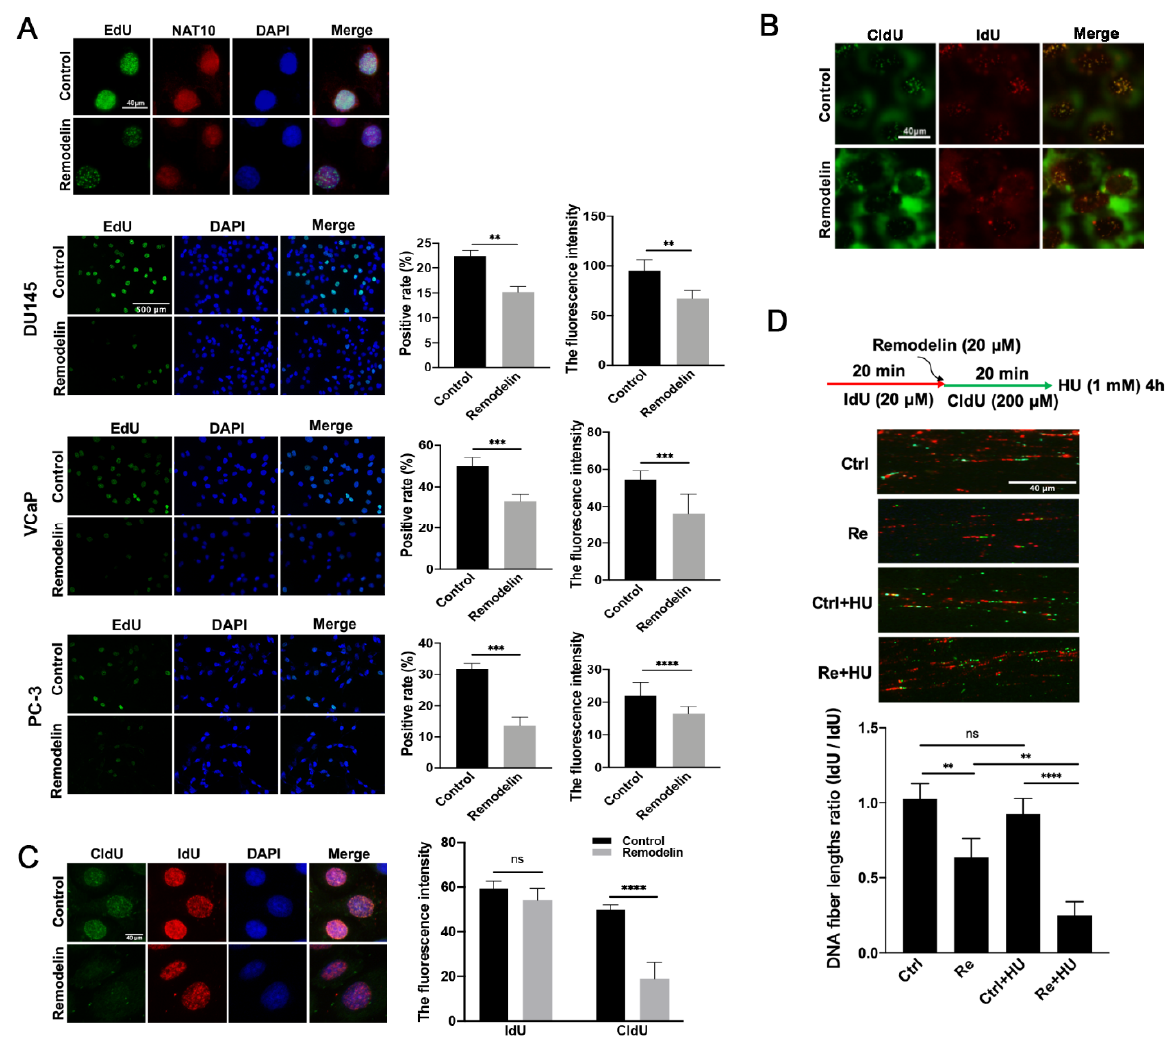
Figure 2. Inhibition of NAT10 slows DNA replication in prostate cancer cells. ( A ) In a variety of prostate cancer cells, Remodelin was used to inhibit the activity of NAT10, and then immunofluorescence co-staining was performed. NAT10 (red) and EdU (green) DAPI (blue) were compared with the control group, and differences in the EdU positive rate and the fluorescence intensity were analyzed. ( B ) Cells were pretreated with Remodelin (20 μ M) for 24 h, treated with IdU (20 μ M) for 20 min, and finally, treated with CldU (200 μ M) for 60 min, and the cells were collected for immunofluorescence co-staining. ( C ) Cells were treated with IdU (20 μ M) for 20 min, followed by Remodelin treatment for 4 h, with the DMSO treatment group as the control, and finally treated with CldU (200 μ M) for 1 h. The cells were collected for immunofluorescence co-staining, IdU (red), CldU (green), DAPI (blue), and the fluorescence intensity were analyzed. T -test; **, p < 0.01; ***, p < 0.001; ****, p < 0.0001. ( D ) DNA fiber assay showing the influence of NAT10 on DNA replication forks. Control: IdU 20 min, CldU 20 min. Control + Hu: IdU 20 min, CldU 20 min, Hu (1 mM) 4 h. Remodelin: IdU 20 min, Remodelin + CldU 20 min, Remodelin + Hu: IdU 20 min, Remodelin + CldU 20 min, Hu 4 h, and the DNA fiber length ratios were analyzed. At least 500 cells were evaluated in each experiment. The representative images in each group are shown, and the data were quantified from triplicate experiments, and are presented as mean ± SD.